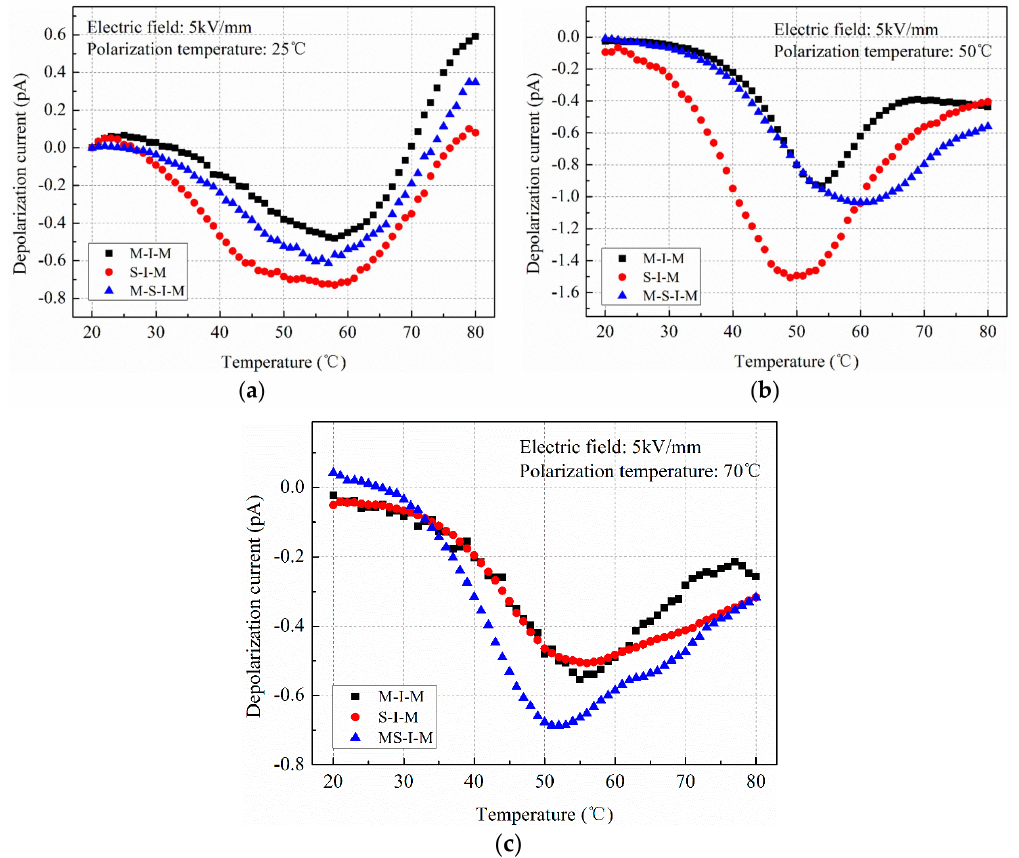
Figure 6. Depolarization current of cross-linked polyethylene (XLPE) polarized using different electrode structures under low electric field with different polarization temperatures. ( a ) 25 °C; ( b ) 50 °C; ( c ) 70 °C.